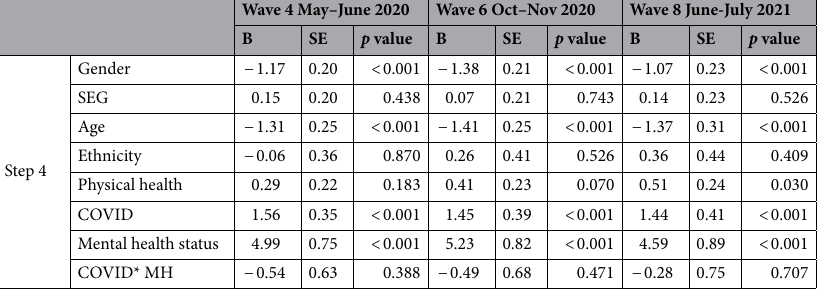
Table 1. Hierarchical regression analyses investigating the associations between probable COVID-19 infection during waves 1–3 (Mar-May 2020) and depression and anxiety at 1 month (May/June 2020), 5 month